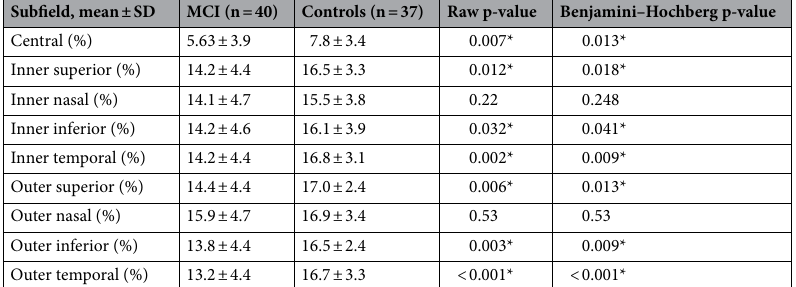
Subfield, mean ± SD